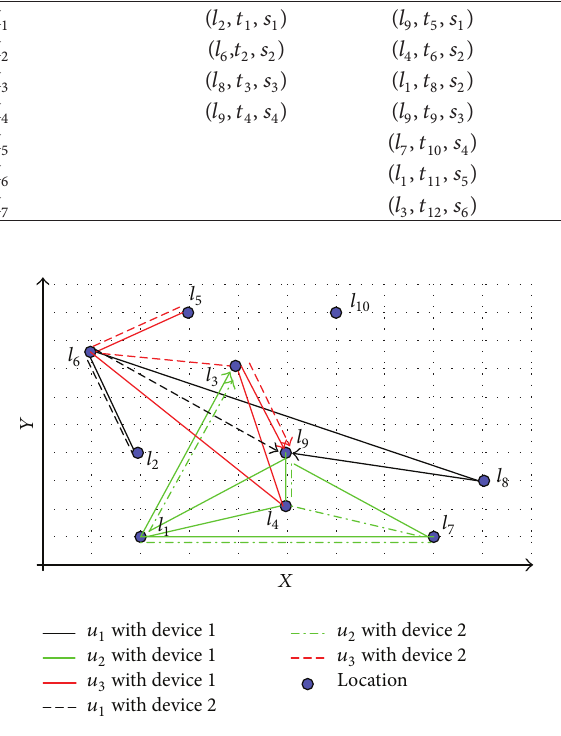
Figure 2: Movement trajectories of customers when they use different devices.